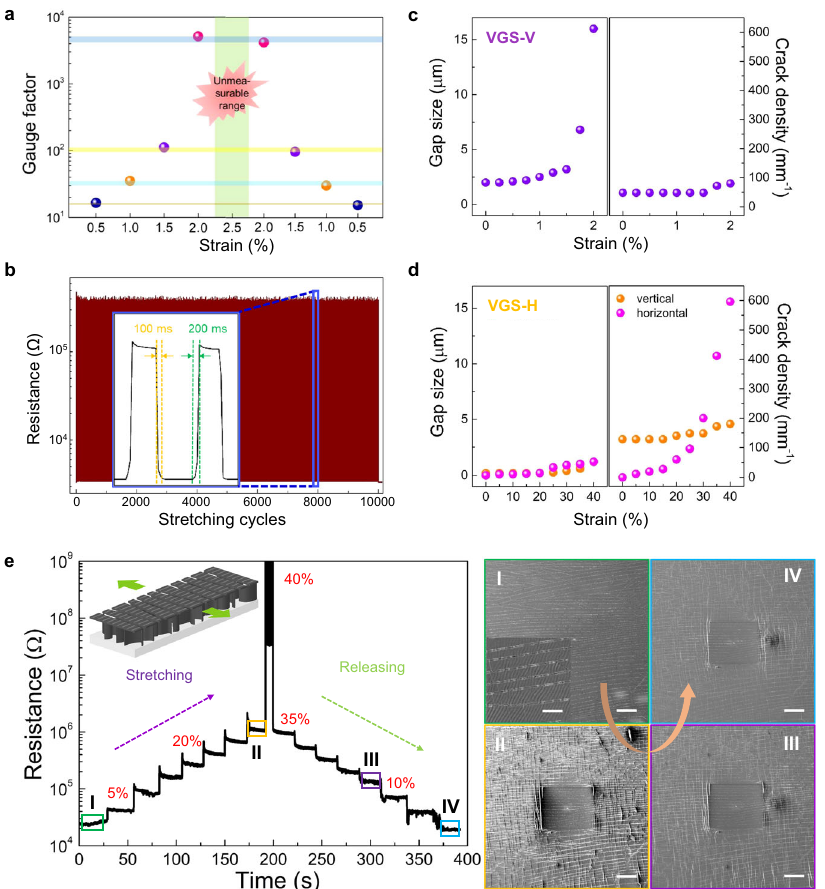
Fig. 3 VGS performance and sensing mechanism. a Gauge factor as a function of strain, estimated from Fig. 2c. Except for 2% strain, no noticeable changes at each strain are observed, indicating highly reversible behavior. The width of highlighted color bars indicates the difference between averaged gauge factors when stretching and releasing at speci fi c strains. b Resistance measured between 0 and 2% strain for 10,000 consecutive cycles with a strain sweep rate of 1 mm/s and 0.1 s hold time at the peak. The response and recovery times are approximately 200 and 100 ms from the enlarged curves in blue box. c , d Gap size between cracks and crack density versus applied strain for VGS-V ( c ) and VGS-H ( d ). In e the ‘ vertical ’ cracks are those formed initially during removal from the SiO 2 substrate and the ‘ horizontal ’ cracks are those newly formed during stretching. e Resistance as a function of time with applied stepwise strain when the elongated direction is parallel to the cracks on the BFG (upper illustration). The resistance approaches in fi nity when the applied strain reaches up to 40%, namely, the current path is broken. But, the resistance recovers to the initial value during release, and the post-overload resistance is almost the same to the pre-overload resistance at each strain. Right panel of e In situ SEM images of VGS-H during stretching (I (0%), green box and II (35%), yellow box)/release (III (15%), purple box and IV (0%), blue box). Scale bars, 200 μ m. Inset in I, enlarged SEM image, clearly showing vertical cracks on the BFG. Scale bar, 50 μ